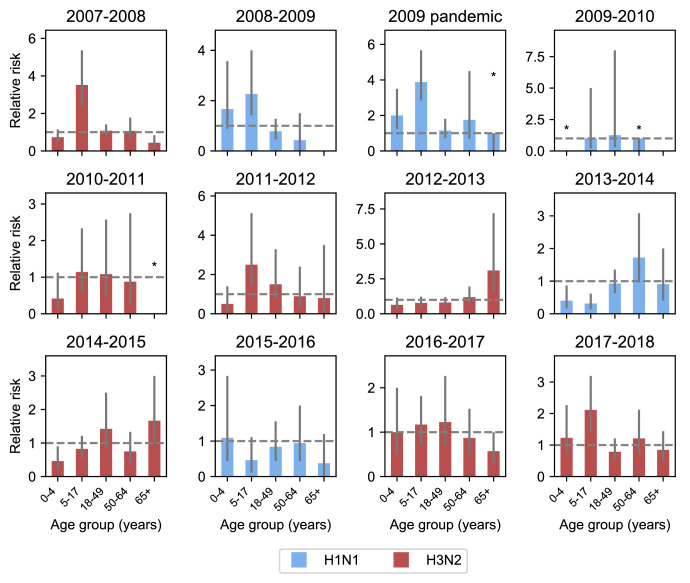
Relative risk among different age groups across seasons.Each panel shows the relative risk of infection in the first versus the second half of an epidemic for different age groups in each season (Materials and methods: ‘Calculating relative risk’). Relative risk greater than 1 (indicated by the grey dashed line) means that an age group was more likely to be infected at during the first rather than second half of an epidemic. Age groups with no cases in the latter half of a season are indicated by asterisks and no bar. The dominant subtype of each subtype is indicated by the bar color. 95% binomial confidence intervals are indicated by grey vertical lines. Bars with asterisks over them indicate that the 95% confidence interval includes the scenario where all cases occur in the first half of the season.